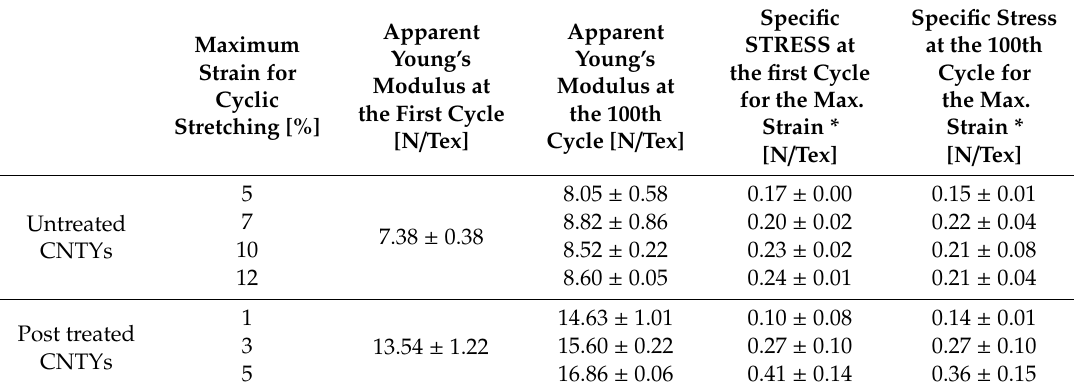
Table 2. E ff ects of cyclic loading on the mechanical properties of CNTYs. Table 2. Effects of cyclic loading on the mechanical properties of CNTYs.